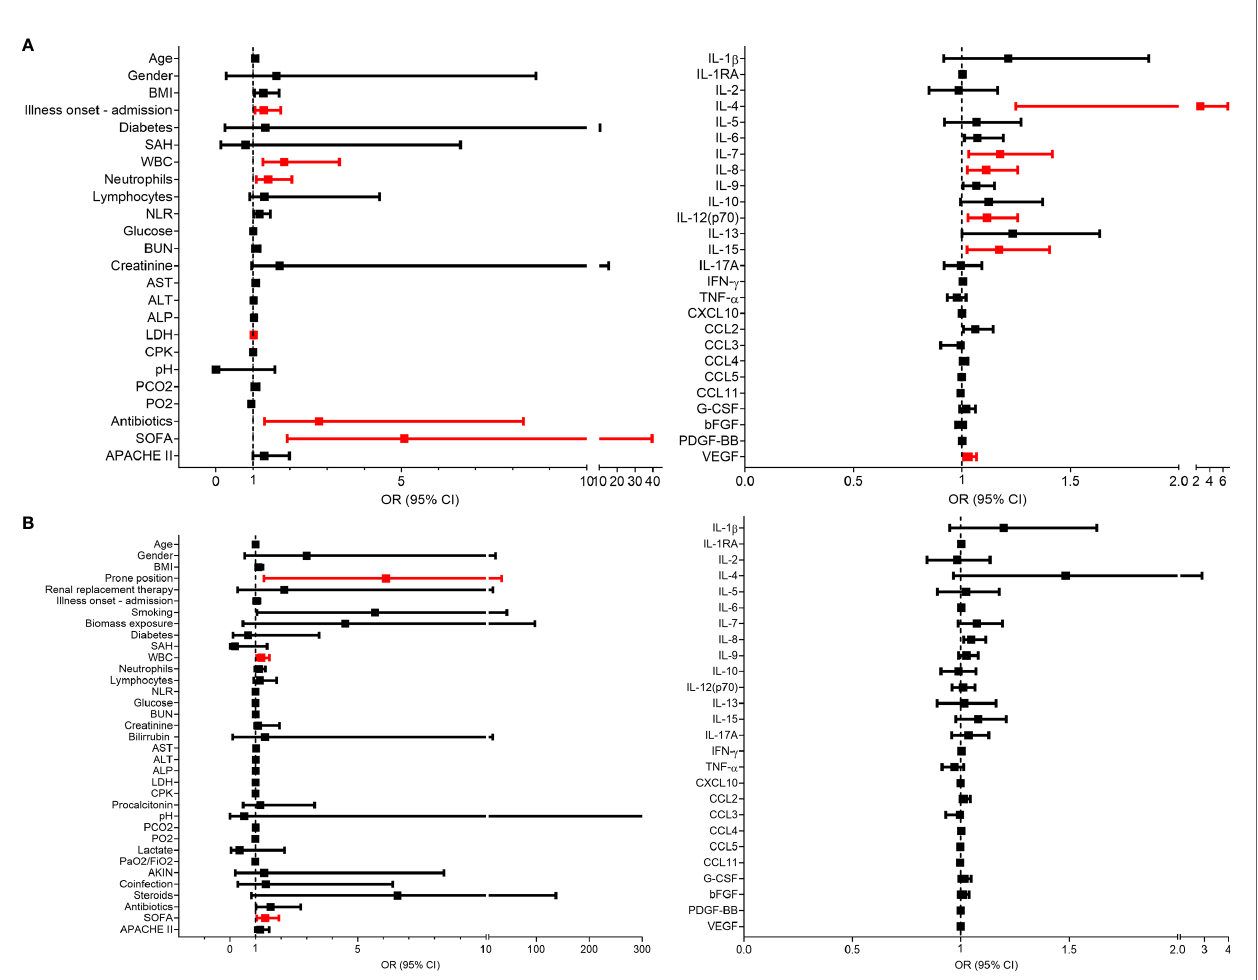
FIGURE 7 | Clinical and immunological factors associated with disease outcomes in patients with COVID-19. (A) Bivariate logistic regression analysis of the clinical and immunological characteristics associated with intubation in patients COVID-19. (B) Clinical and immunological factors associated with mortality in patients with COVID-19. The forest plots show the odds ratio (OR) and 95% CI interval values. OR values that did not include the null value in the 95% CI were considered signi fi cant for intubation/mortality and are shown in red color. Absolute OR values are also presented in Supplemental Table 5